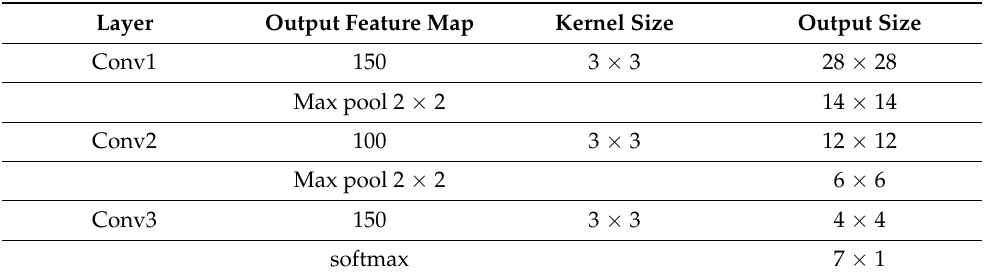
Table 3. Outputs for CNN model of sequential_14. (Model: “sequential_14” with kernel size 3 × 3 of original size 30 × 30).